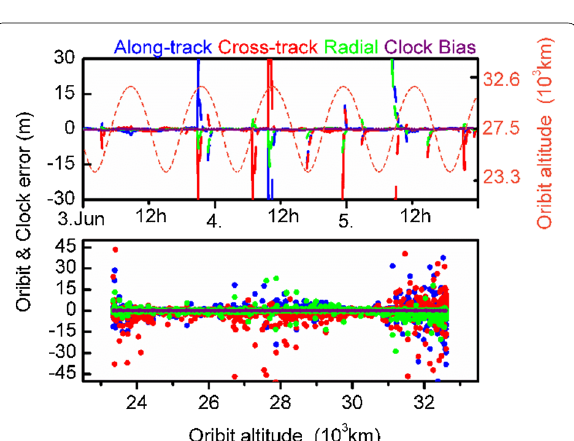
Fig. 5 Time series of orbit errors, clock bias and orbit altitude ( top ) of Galileo E14 (June 3–5 2018) and orbit errors and clock bias of E14/E18 versus orbit altitude ( bottom ) in June